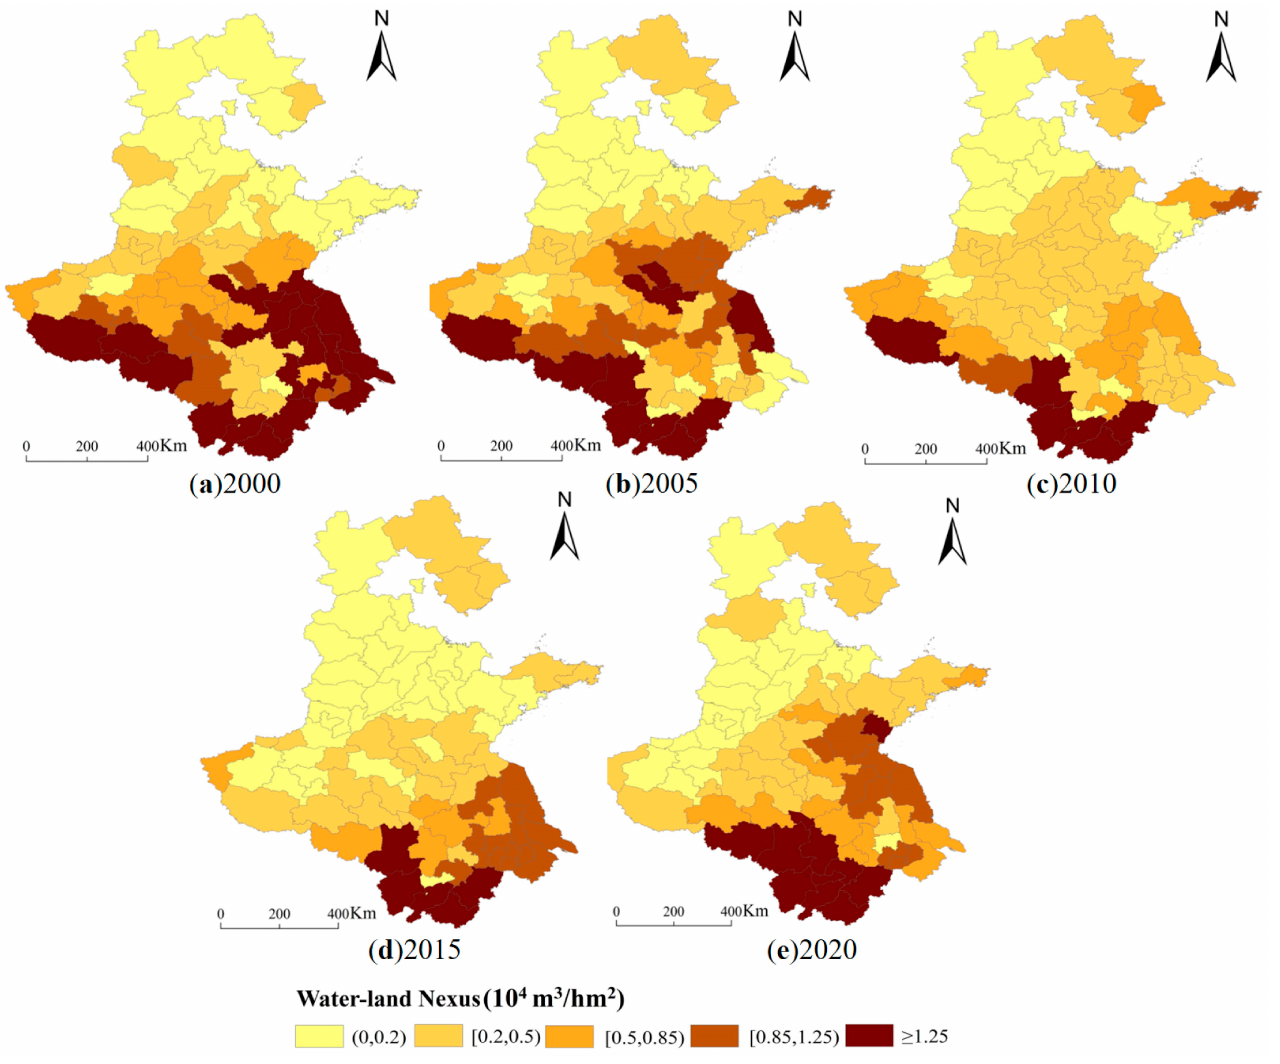
Figure 6. Spatial and temporal variation of the water–land nexus. ( a ) 2000 ( b ) 2005 ( c ) 2010 ( d